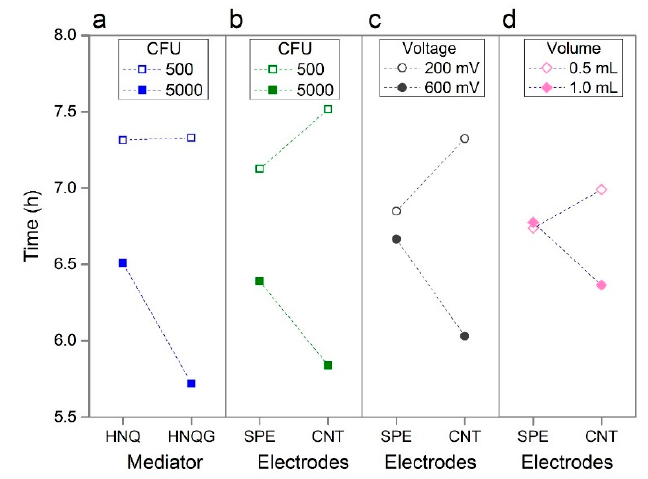
Figure 3. Interaction plots showing four prominent interactions: Mediator vs Inoculum Size (a); Electrodes vs Inoculum Size (b); Electrodes vs Voltage (c); Electrodes vs Volume (d).